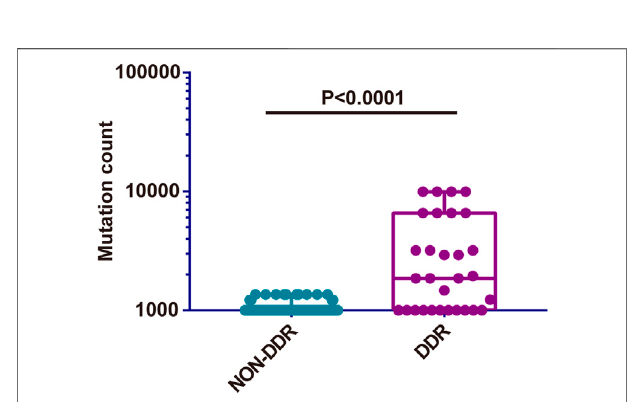
FIGURE 7 | Comparison of somatic mutation count between non-DDR and DDR groups from TCGA cohort. DDR: DNA damage response; TCGA: The Cancer Genome